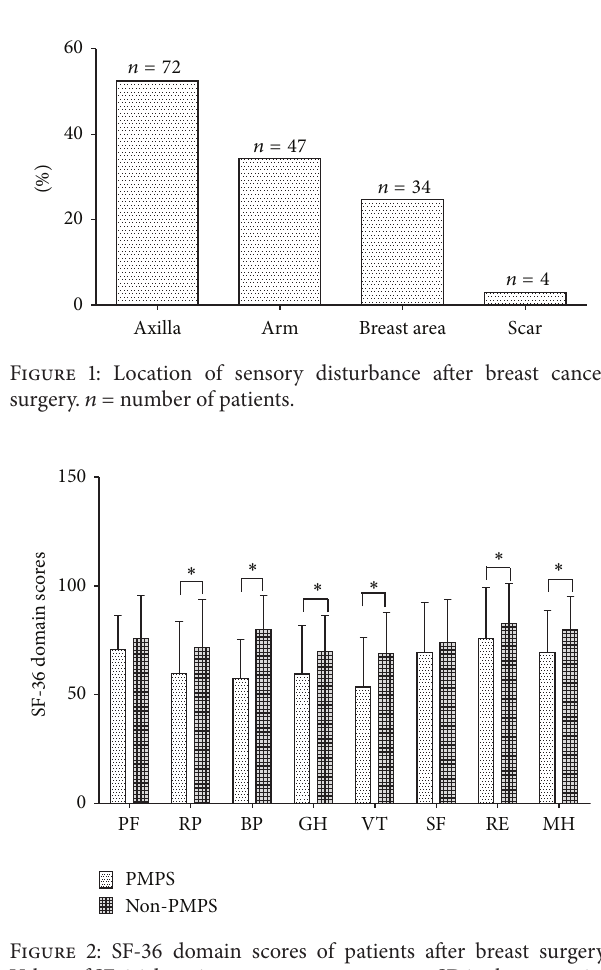
Figure 2: SF-36 domain scores of patients after breast surgery. ValuesofSF-36domainscoresrepresentmean ± SDintherespective group. PMPS, postmastectomy pain syndrome; Non-PMPS, no postmastectomy pain; PF, physical function; RP, role limitations due to physical problems; BP, body pain; GH, general health; VT, vitality; SF, social function; RE, role limitations due to emotional problems; MH, mental health. ∗ Significant result, 𝑃 < 0.05